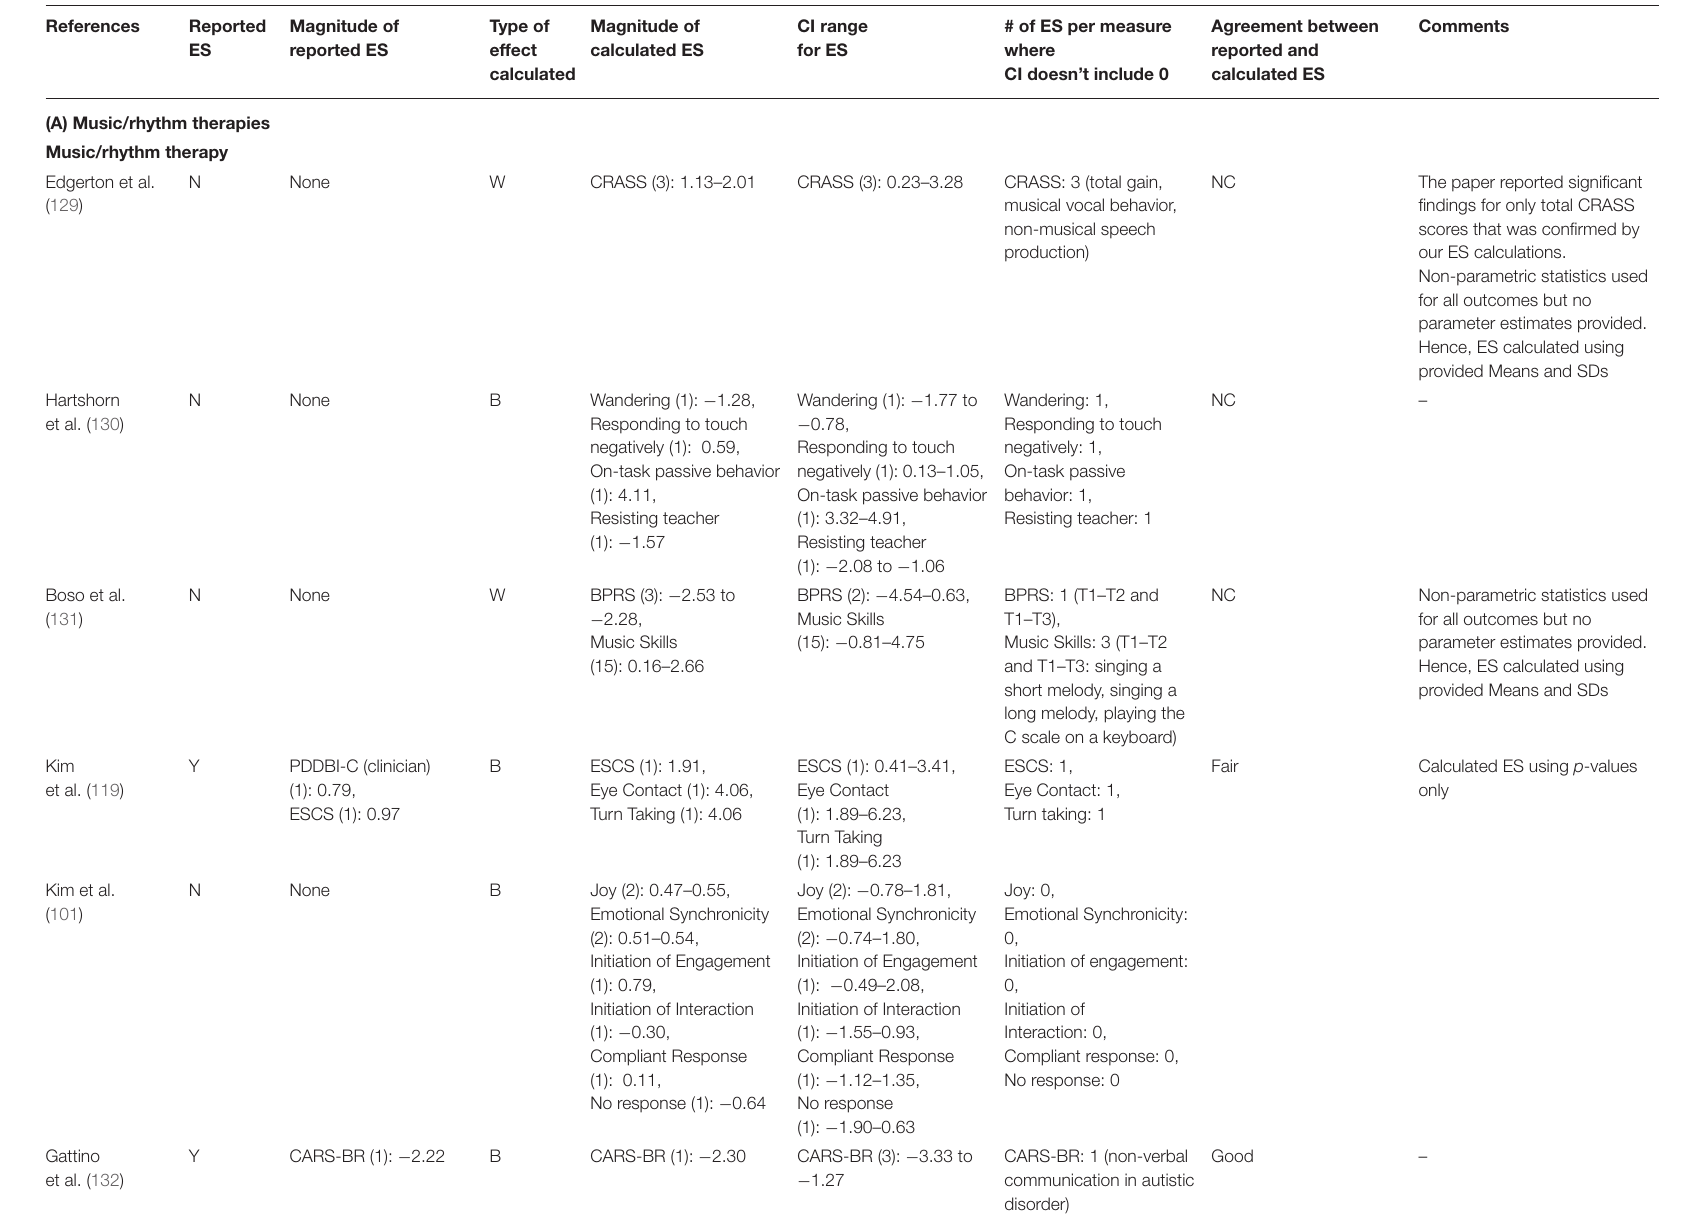
TABLE 4 | Study-wise list of reported and calculated effect